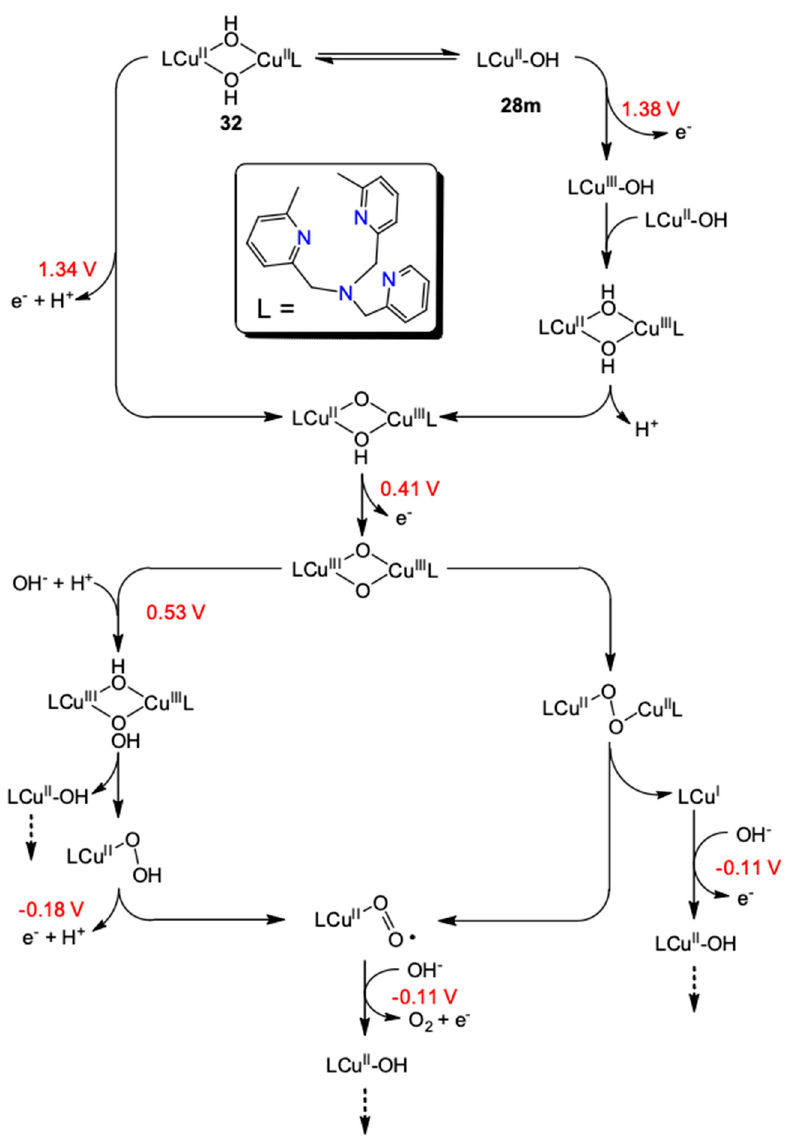
Figure 21. The most probable mechanistic scenario for 32 according to Kieber-Emmons [75].